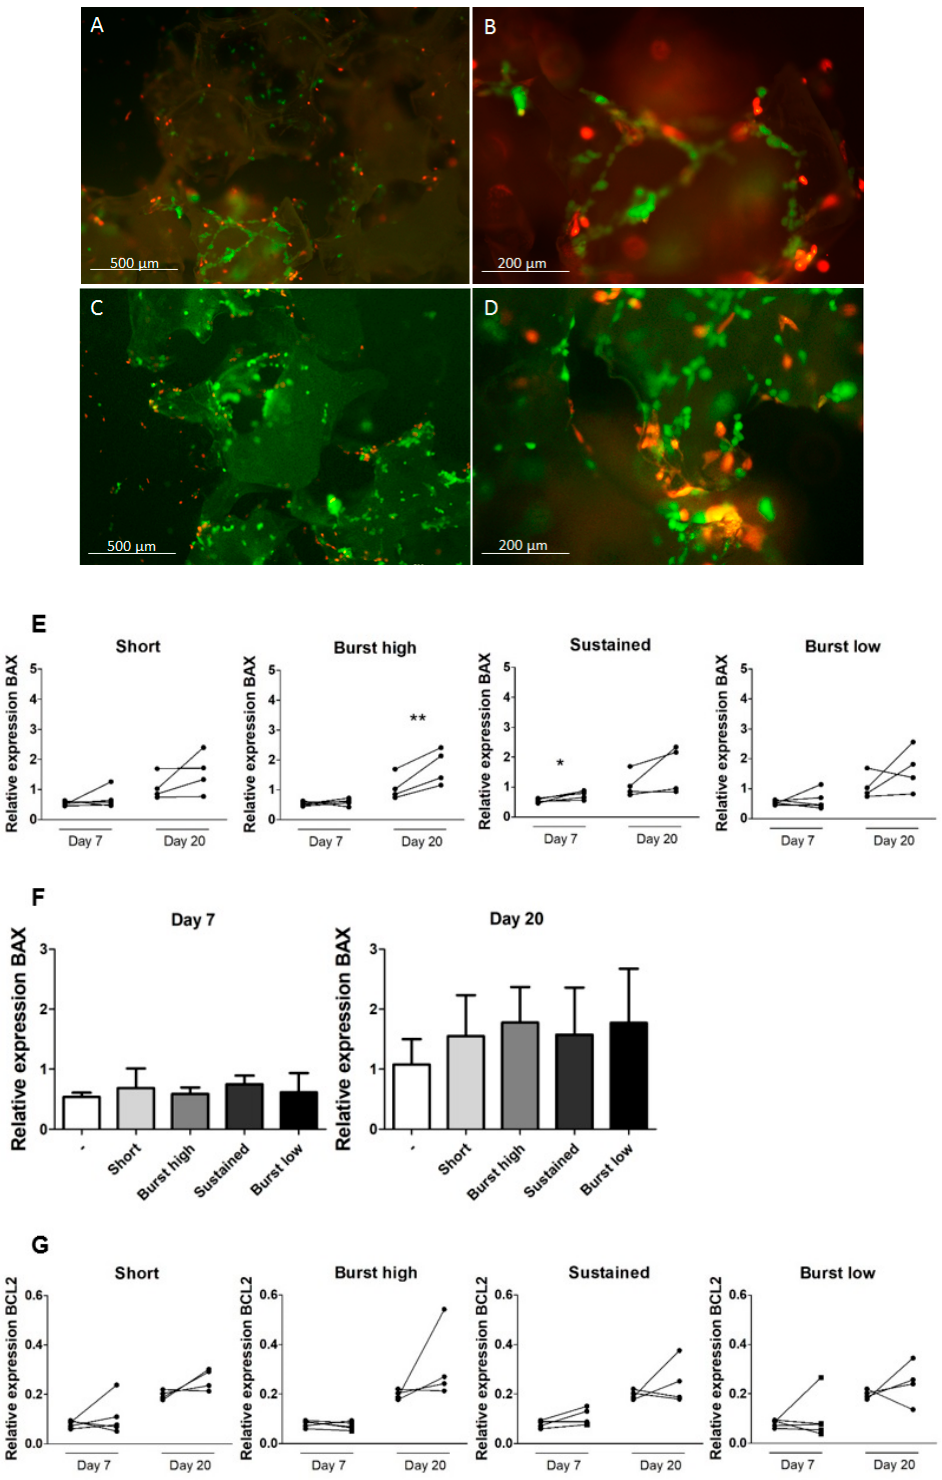
Figure 2. E ff ect of vitamin D 3 on the viability of hASCs on BCP particles. Fluorescence microscopy of live / dead staining shows the attachment and viability of hASCs on Day 2 after seeding. Living cells are stained green, while the red-stained cells are dead / dying. ( A , B ) Sample without vitD 3 treatment, where (B) is a higher magnification of the same sample as (A). ( C , D ) A representative sample with vitD 3 treatment (highest concentration, i.e., [200 nM]) is depicted. Both (C,D) were made in the same